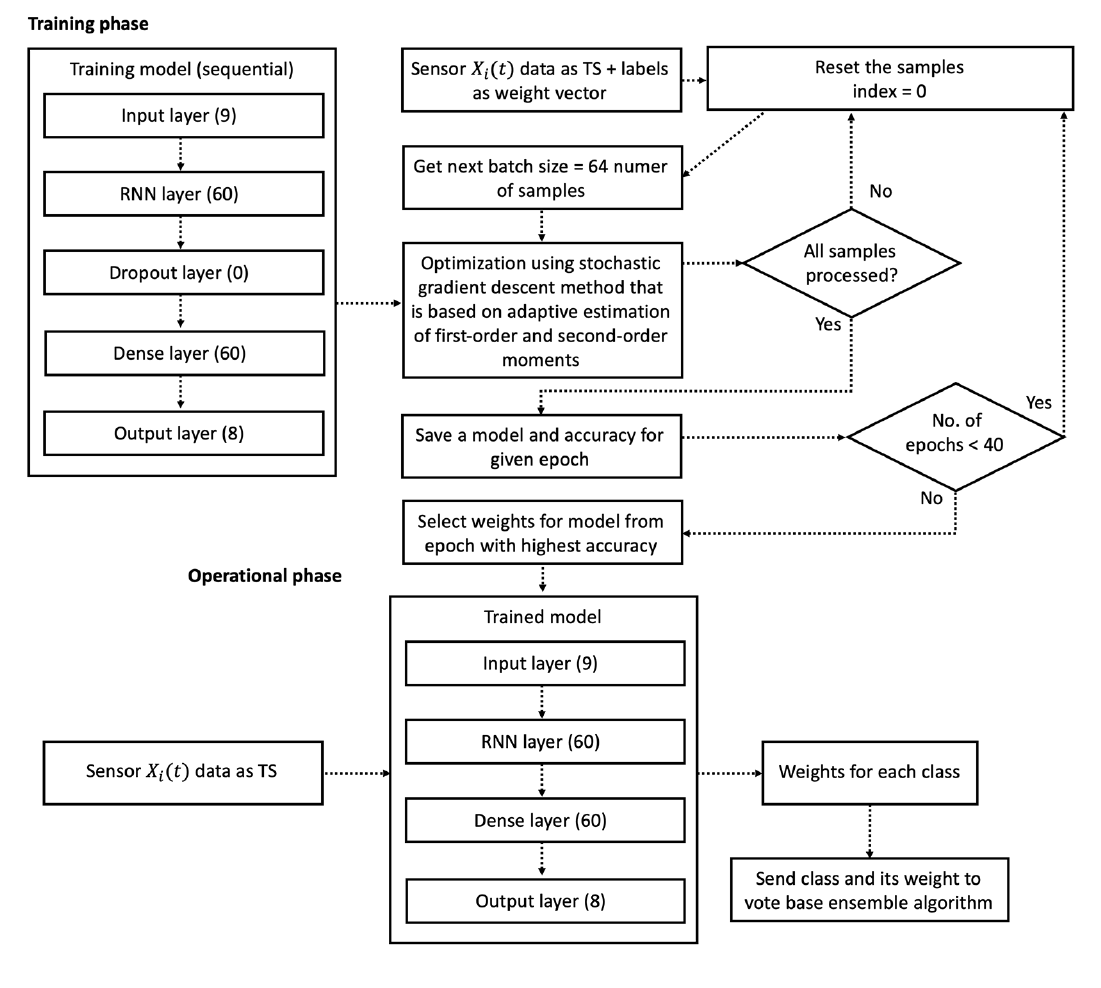
Figure 3. Training and operation of the RNN model for activity